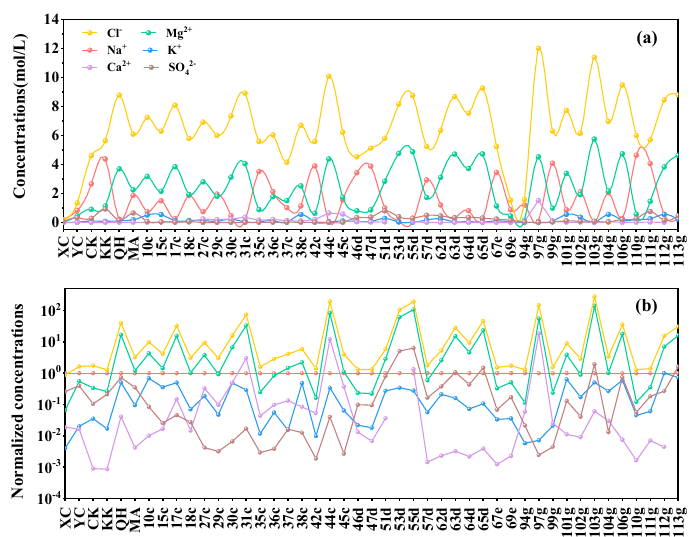
Figure 3. ( a ) Ionic concentrations of brine samples. ( b ) Na-normalized ionic concentrations of brine samples. The letters after the numbers indicate the literature source, and the detailed literature information can be found in Table S1. c from [43,44], d from [45], e from [46], g from [47,48]. The correlations between the ions are quantified and the results are shown in Table 1.